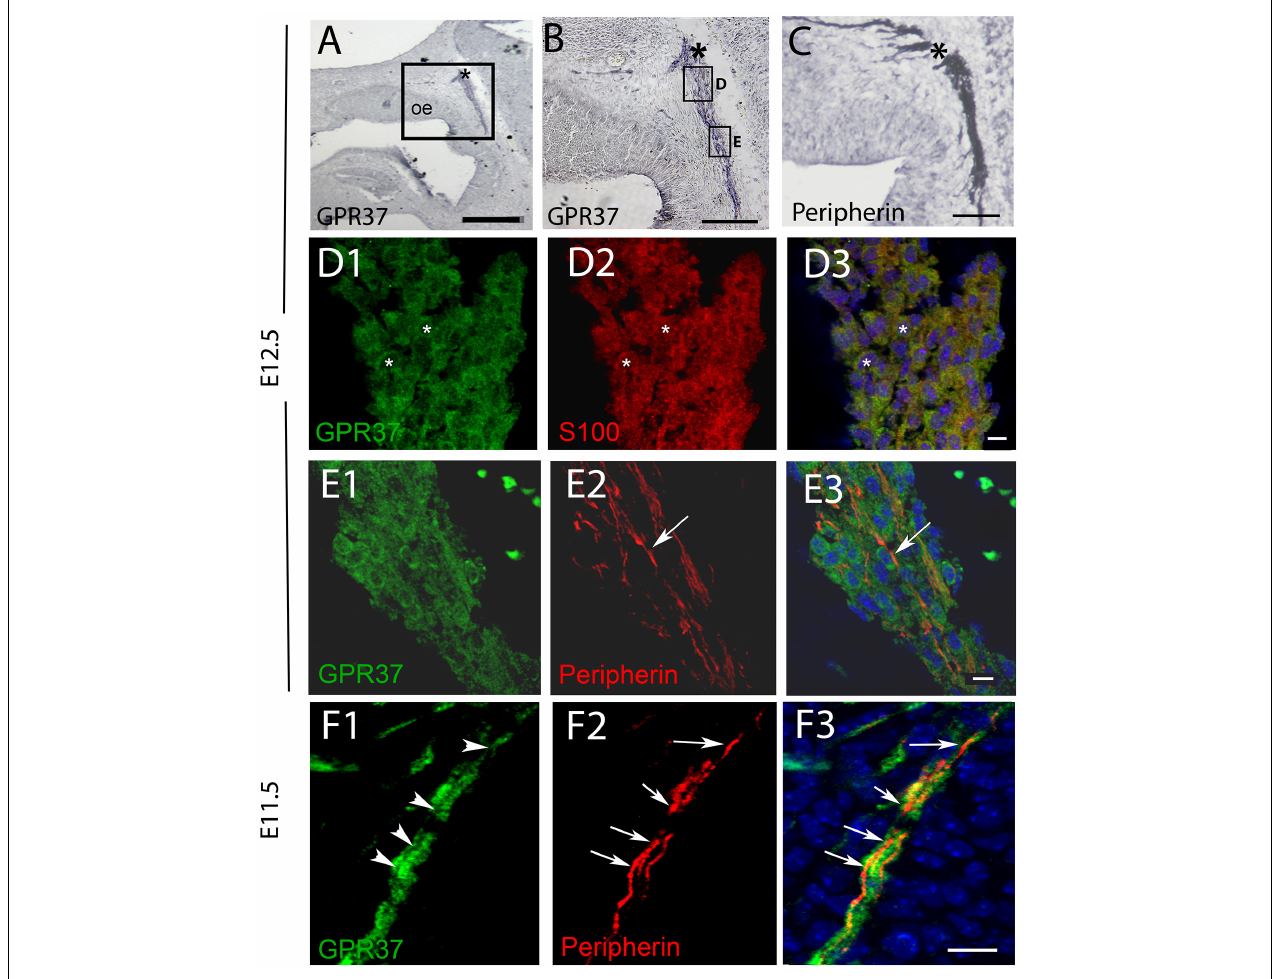
FIGURE 3 | GPR37 is expressed in OECs but not in OSAs. (A,B) GPR37 expression detected in migratory tracks and nasal forebrain junction ( ∗ ) coincides with regions stained for OSA (peripherin staining, C ). However, immunofluorescent staining showed GPR37 (green) colocalized with OECs (red, D , S100, same cells shown with small white asterisks) but not with OSAs (E,F) . (E) Arrow highlights single peripherin fiber that is GPR37 negative at E12.5 (E) . GPR37 positive elements are likely OECs which surround OSAs (see schematic Supplementary Figure 3 ). (F) Arrows (F2,F3) point to OSAs (red) that are GRP37 negative, shown in ( F1) (arrowheads) at E11.5. (D3–F3) Merged images of corresponding row. (A–G) , E12.5; (H) E11.5. Scale bar: (A) = 200 µ m, (B,D) = 100 µ m, (E) = 20 µ m, (F) = 10 µ m. See Supplementary Figure 2 for surface rendering